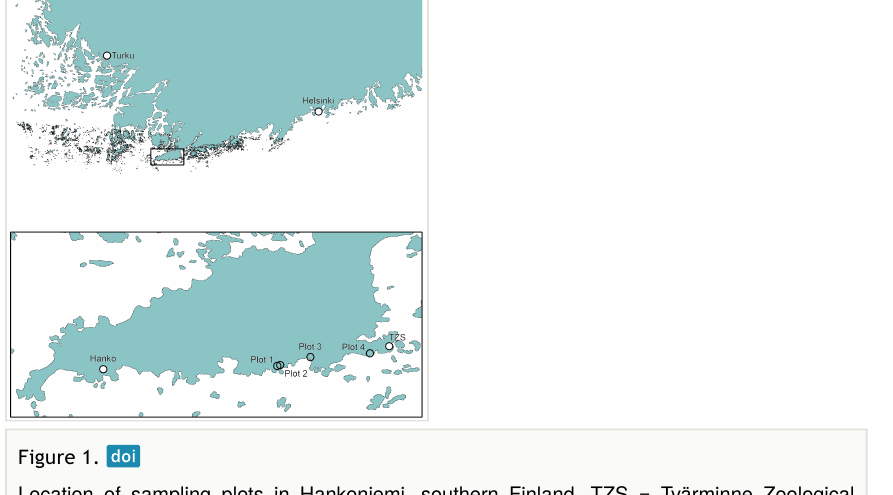
Figure 1. Location of sampling plots in Hankoniemi, southern Finland. TZS = Tvärminne Zoological